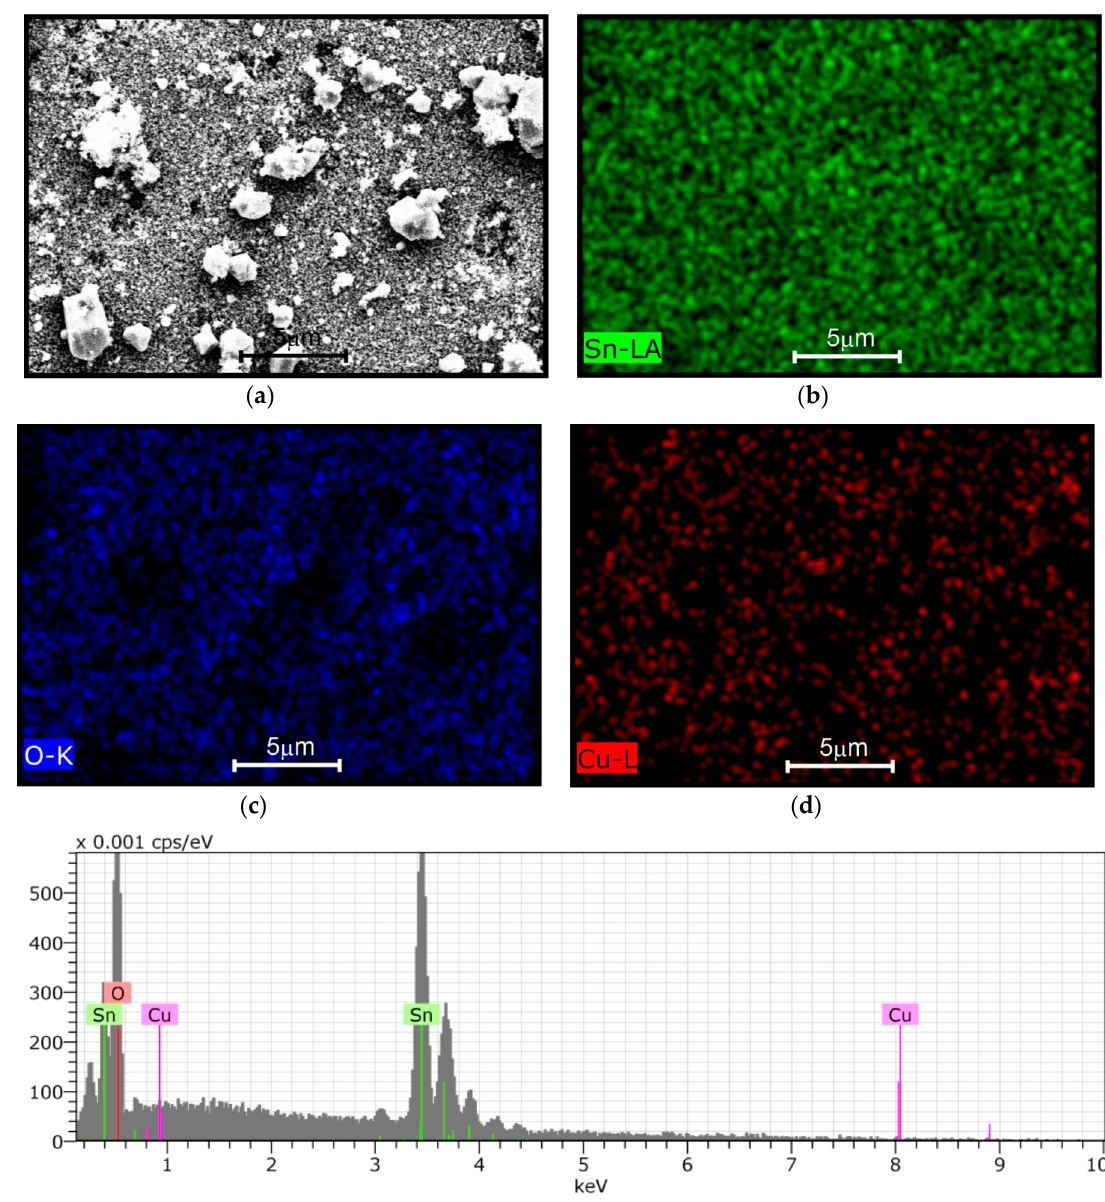
Figure 4. EDAX analysis of ( a ) Cu:SnO 2 powders surface with clusters ( b ) Sn; ( c ) O; ( d ) CuO; and ( e ) composition plot with inset confirming the wt % of each element.